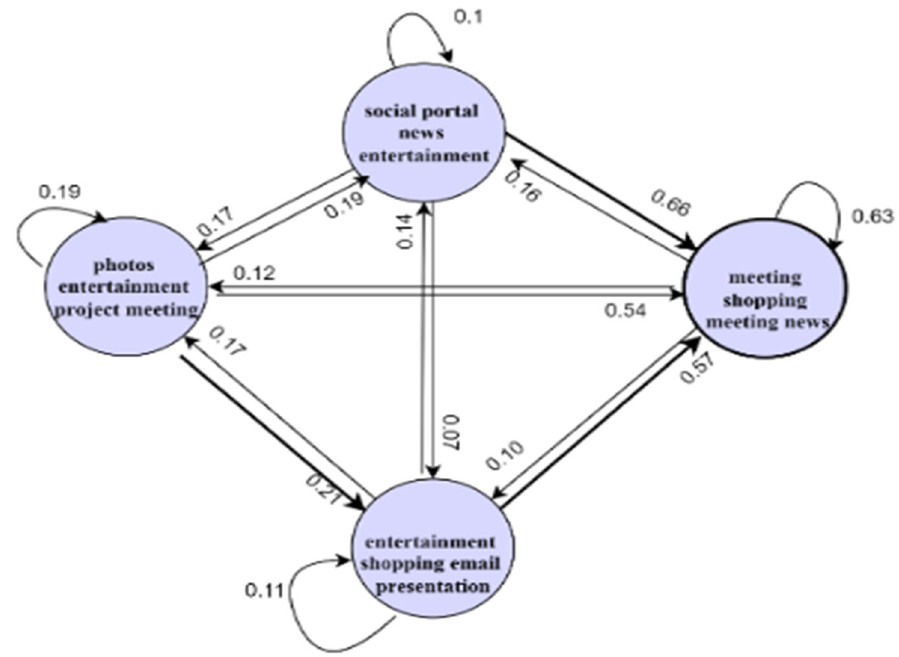
Figure 15. Behaviour model from P3.